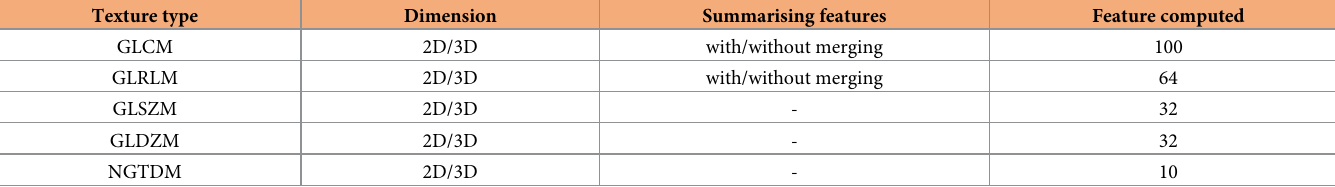
Table 2. Radiomic features extracted from contrast and non-contrast enhanced CT images. GLCM, grey level co-occurrence matrix; GLRLM, grey level run length matrix; GLSZM, grey level size zone matrix; GLDZM, grey level distance zone matrix; NGTDM, neighbourhood grey tone difference matrix. Texture